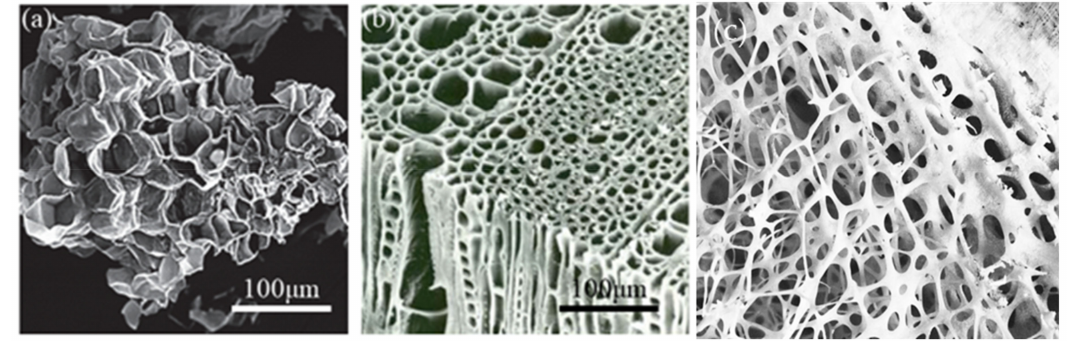
Figure 4. Examples of cellular microstructure in nature; ( a ) micro cork particle [44], ( b ) wood [45], and ( c ) bone